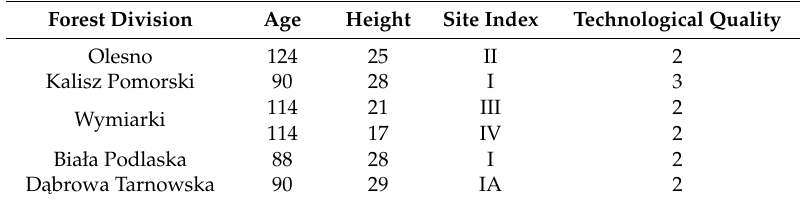
Table 1. Details of the areas covered by the study (excerpt from forest management plans). Forest